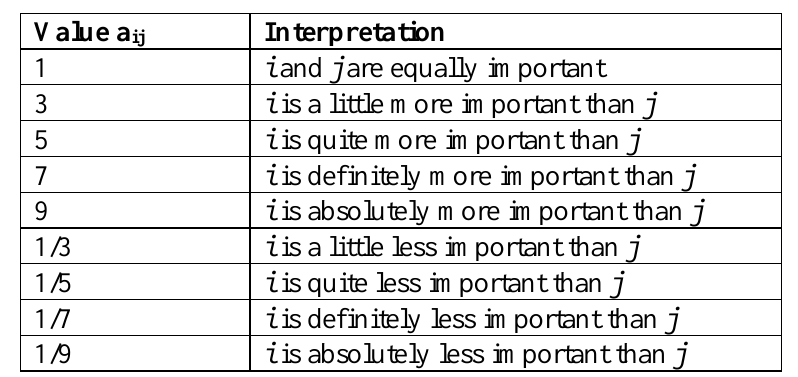
Table 4.1 Scale of